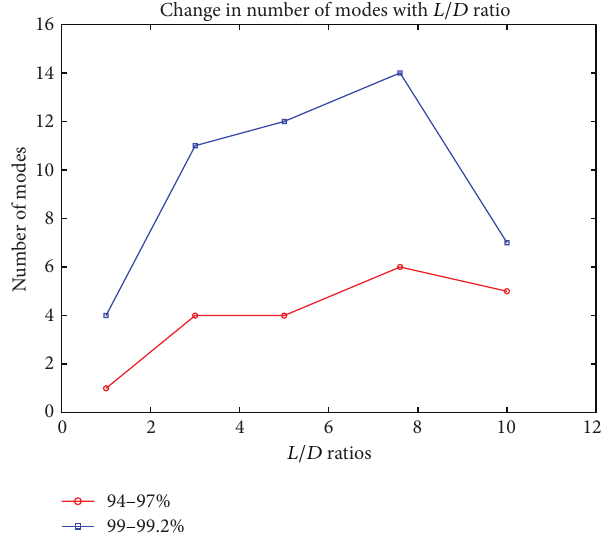
Figure 14: Change in the number of POD modes with L/D ratios.